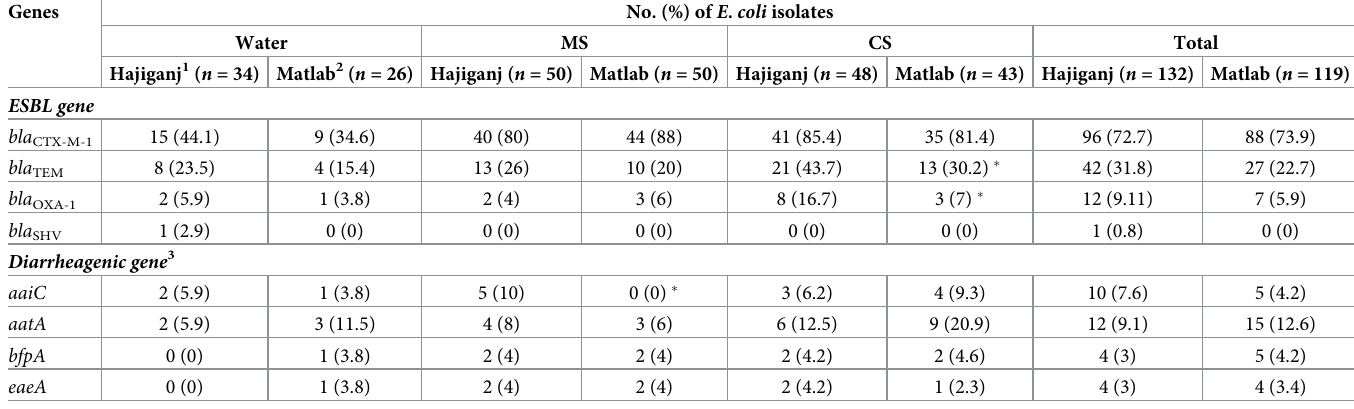
1 Hajiganj, high arsenic exposure. 2 Matlab, low arsenic exposure. 3 EAEC ( aaiC , aatA ), EPEC ( bfpA , eaeA ), EIEC ( ipaH , ial ), ETEC ( lt , st ), STEC ( stx1 , stx2 ); None of the isolates were positive for ipaH , ial , lt , st , stx1 , and stx2 genes. � indicates statistical significance ( p < 0.05) for the number of isolates positive in Hajiganj compared to Matlab. Prevalence of ESBL and diarrheagenic genes in E . coli from high and low arsenic areas